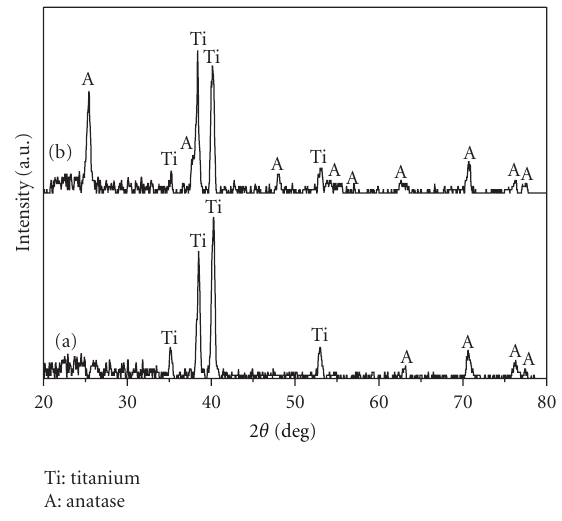
Figure 3: XRD pattern of TiO 2 nanotube arrays: (a) as-anodized TiO 2 nanotube arrays, (b) annealed TiO 2 nanotube (TNTs) arrays at 500 ◦